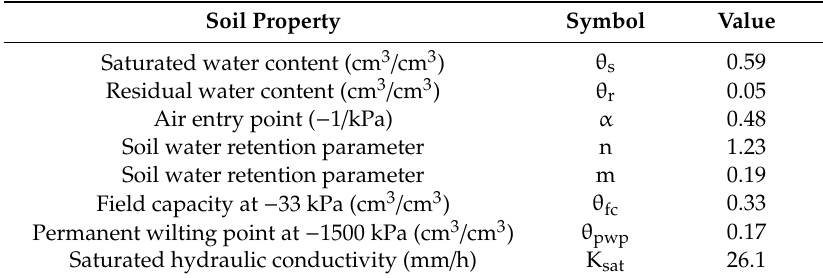
Table 1. Soil hydraulic property parameters from the soil water release